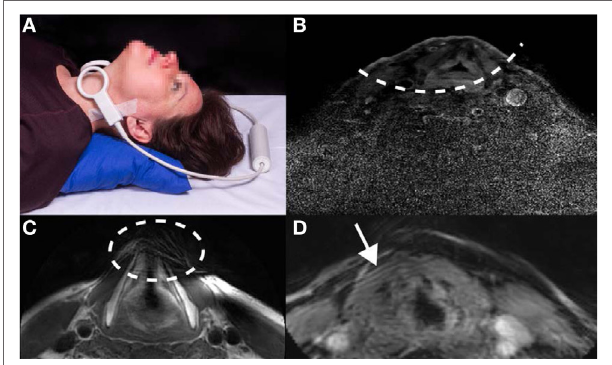
FIgURe 1 | Illustrations of the challenges associated with current approaches to laryngeal magnetic resonance imaging. (A) Two individual, commercial circular receive coils, each with a diameter of 4 cm, are placed around the larynx. Positioning in this particular setup is critical for imaging the larynx and can be experienced as uncomfortable by the subject since the loops have to be held firmly in place with tape and/or velcro straps. Written informed consent was obtained from the subject for publication of this photo. (B) Images acquired with a limited penetration depth due to incorrect coil positioning, (c) images showing signal voids in the anterior part of the larynx due to incorrect coil positioning, and (D) images showing movement artifacts due to subject breathing.